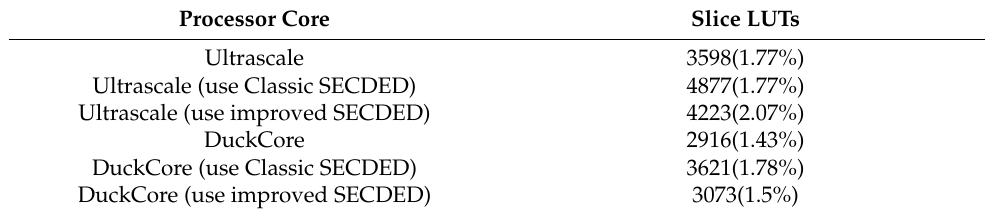
Table 3. Comparison of resource occupation under different